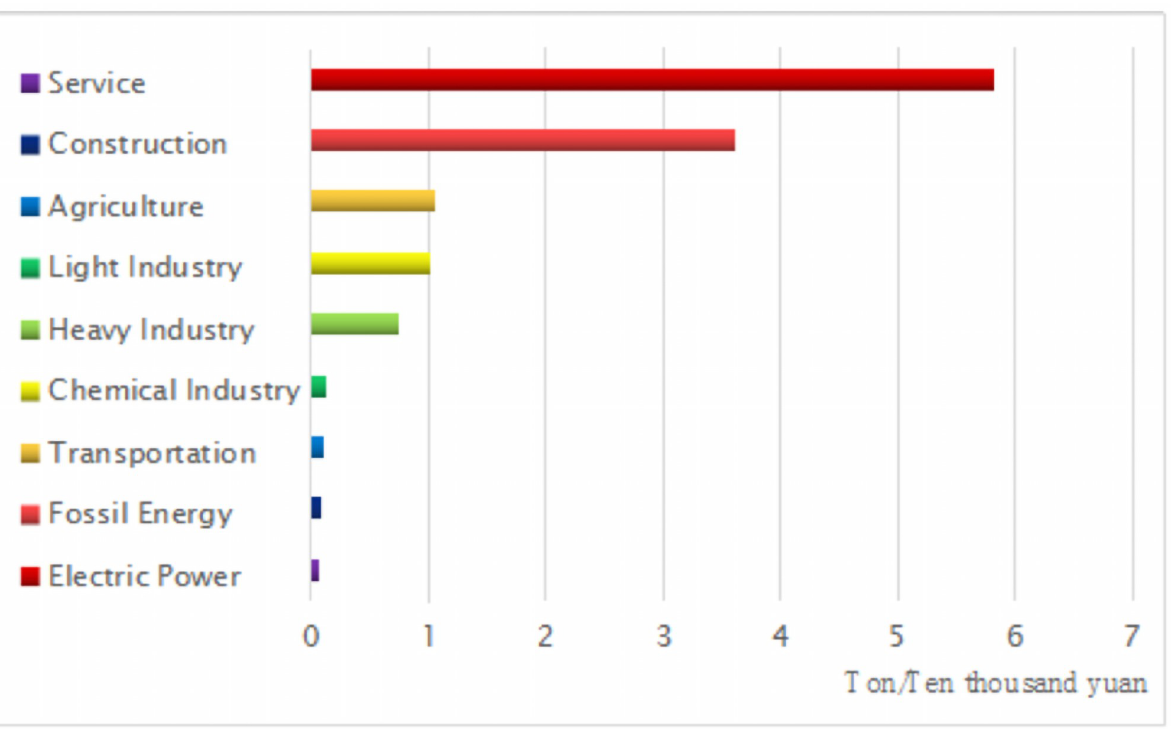
Fig 6. The CO2 emissions efficiency from different